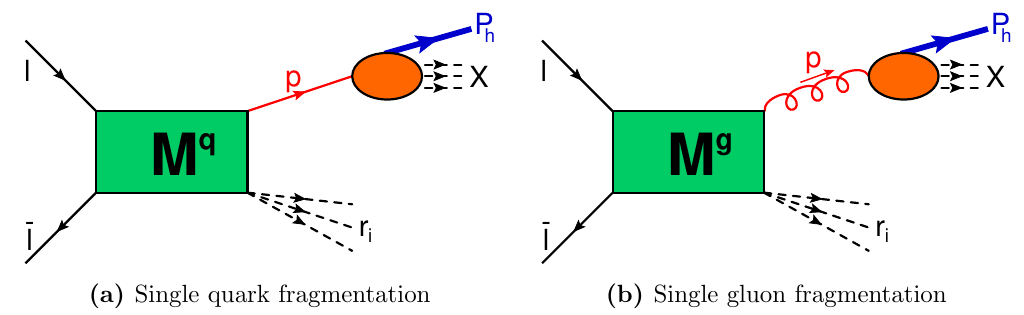
(b) Single gluon fragmentation